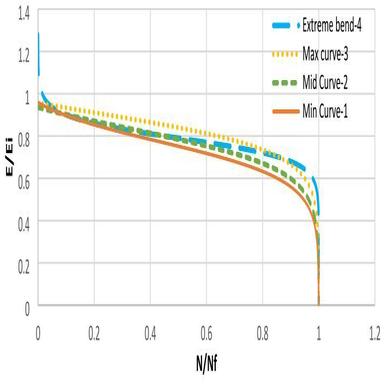
Four different master curves that cover the entire band of normalised modulus degradation curves obtained for all the FBS mixtures.